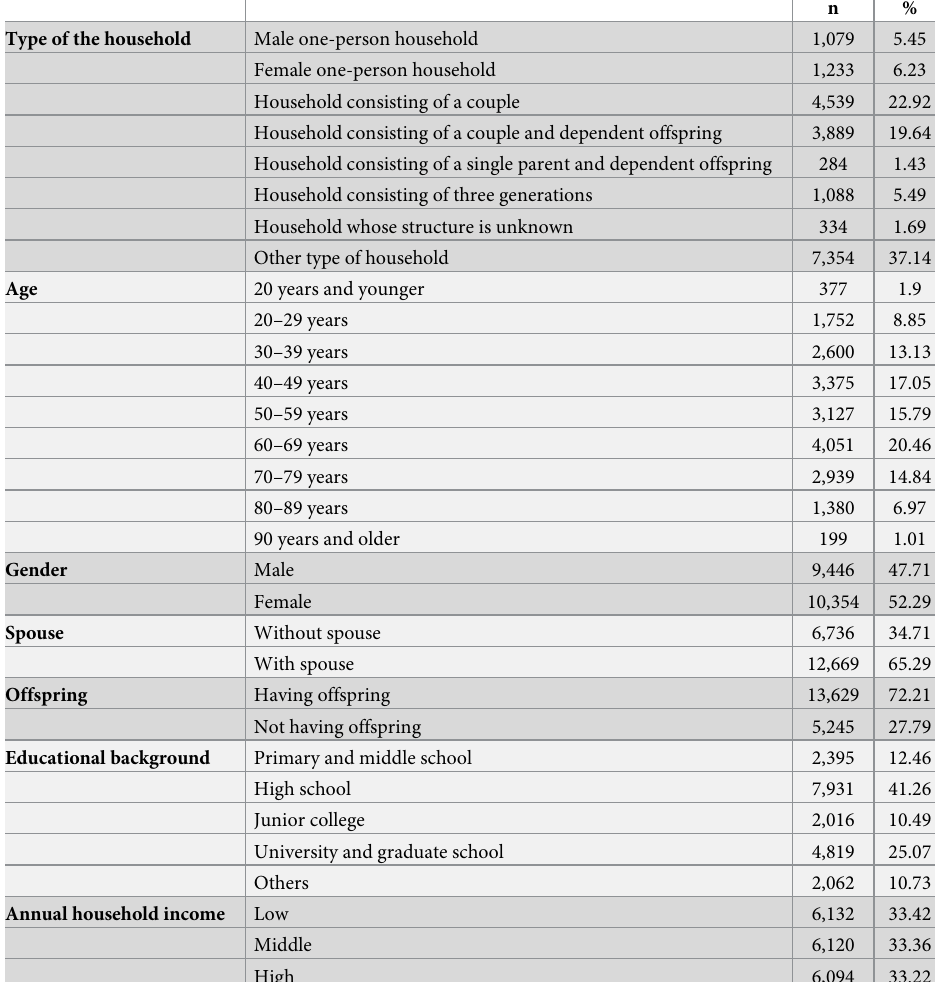
Table 1. Basic demographic characteristics of participants